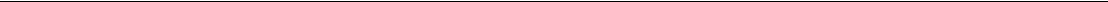
Fig. 7 Early (TF + week 53) phase of Env “ 4-valent ” sequential immunization rescues unedited (anergic) mature B cells in CH103 germ line knock-in mice. a Representative FACS dot plot histograms of IgG-switched splenic memory B cells in control or experimental groups denoted. Shown is transmitted-founder (TF) Env reactivity of splenic IgG + memory B cells, either gated for wild-type (WT) TF Env (non-differential; upper row) or differential, that is, lineage- speci fi c ( Δ 371 TF − vs. WT TF+; lower row) gating strategies. Data are shown after second immunizations in CH103 unmutated common ancestor (UCA) heterozygous (het) double knock-in (dKI) (V H DJ H +/ − × V λ J λ +/ − ) mice. Gating was performed on live, class-switched memory (B220 + CD19 + CD93 − CD38 + IgG + IgM − ) B cells. b Graphical representation of differential-binding IgG + memory B cells per mouse spleen. Circles represent individual mice, and means are denoted by black bars. ** P < 0.005, two-tailed Student ’ s t test. c Area under the curve (AUC) (mean + SEM) ELISA binding of serum IgG + from TF